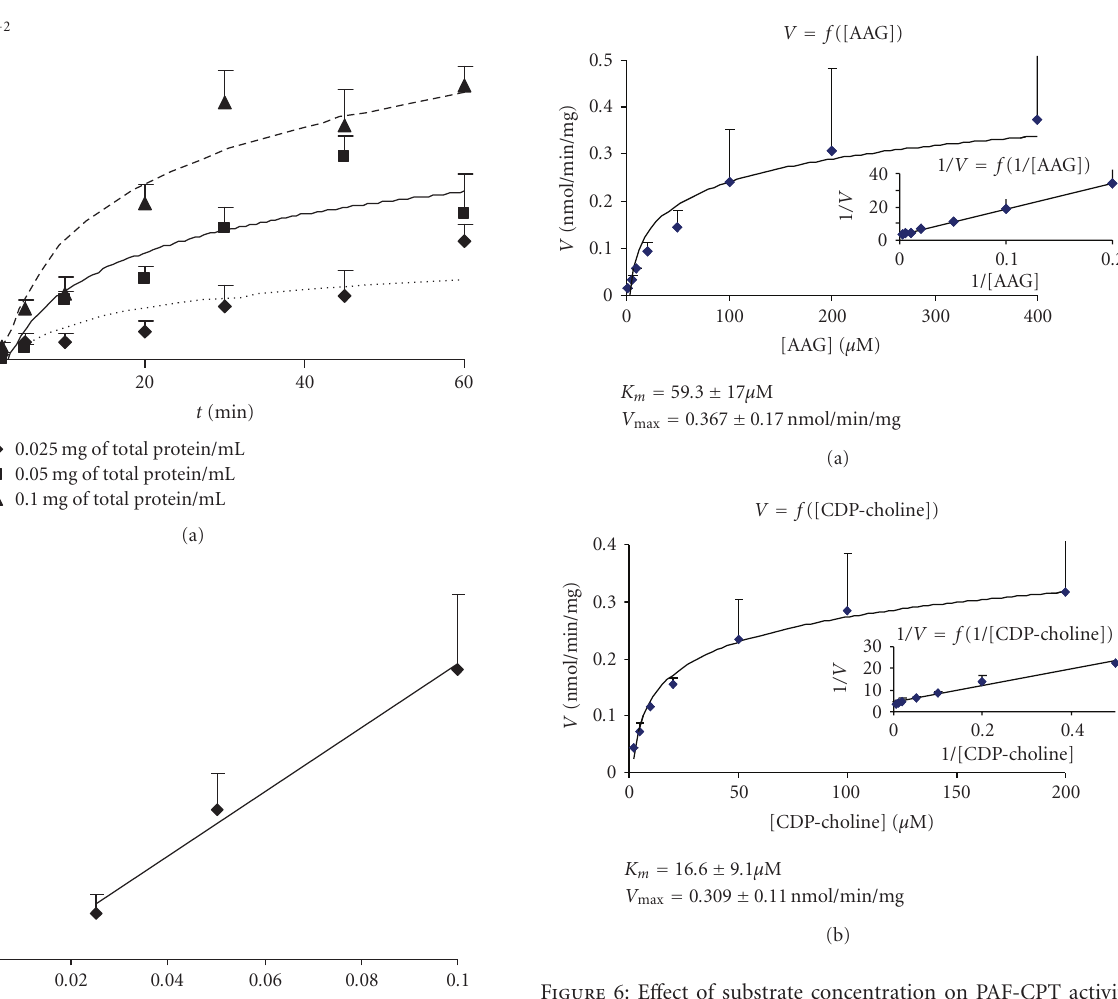
Figure 6: E ff ect of substrate concentration on PAF-CPT activity: (a) activity of PAF-CPT as a function of AAG at fixed concentra- tion of CDP-choline (100 μ M) and the relative Lineweaver-Burk plot; (b) activity of PAF-CPT as a function of CDP-choline at fixed concentration of AAG (100 μ M) and the relative Lineweaver-Burk plot. Experiments were performed at microsomal fractions using 0.05 mg/mL protein in optimum conditions. Results represent the average ± SD of three independent determinations using di ff erent enzyme preparations performing duplicate